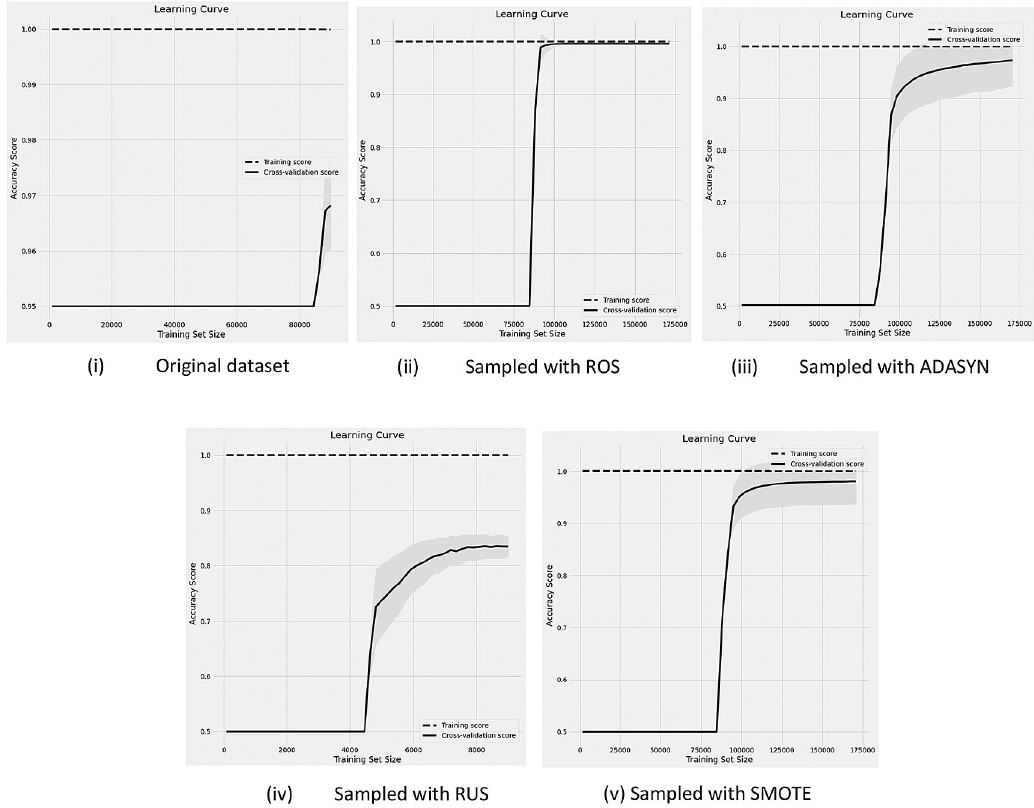
Figure 2. Before and after sampling results of learning curves with the data (95%-5% of non-churn and churn rate) with RF